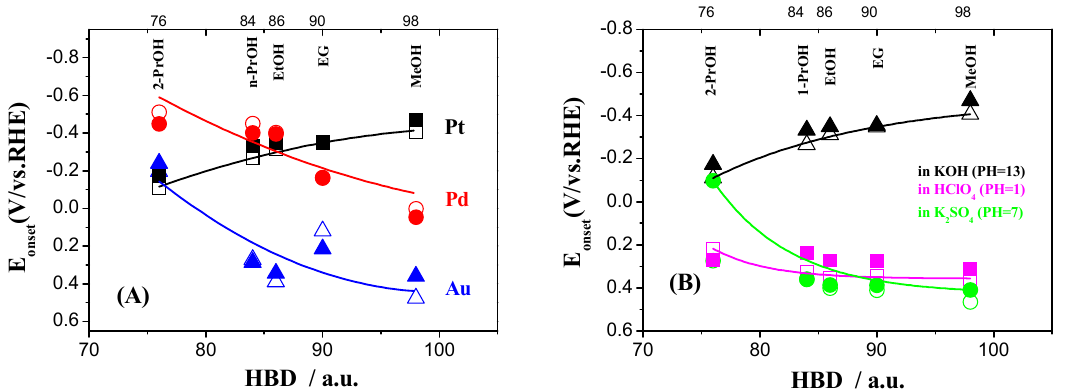
Figure 11. Correlations between electro-oxidation performance and hydrogen bond donation ability (HBD) of alcohols over different electrodes in 0.1 M KOH solution ( A ) and over a Pt electrode in different solutions ( B ). Hollow icons are for metal disk electrodes; solid icons are for nanocatalyst covered GC disk electrodes.